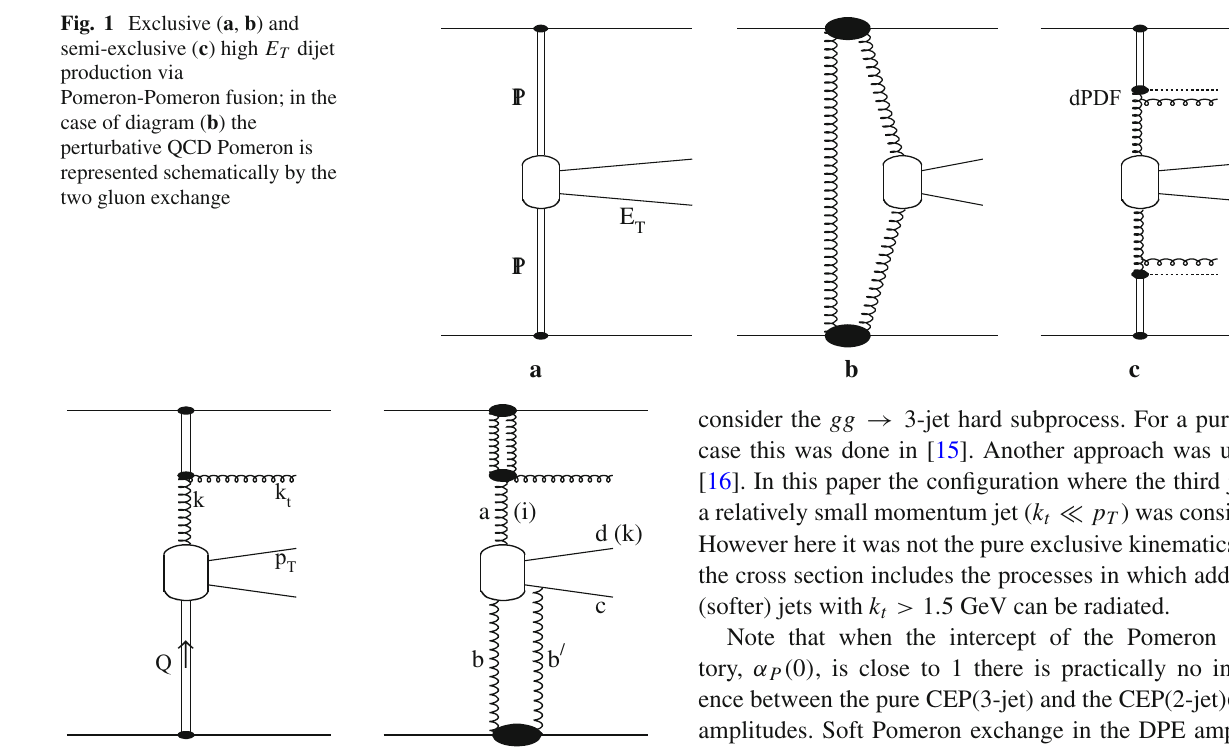
in [6,13] and implemented in Monte Carlo generators, like e.g. POMWIG